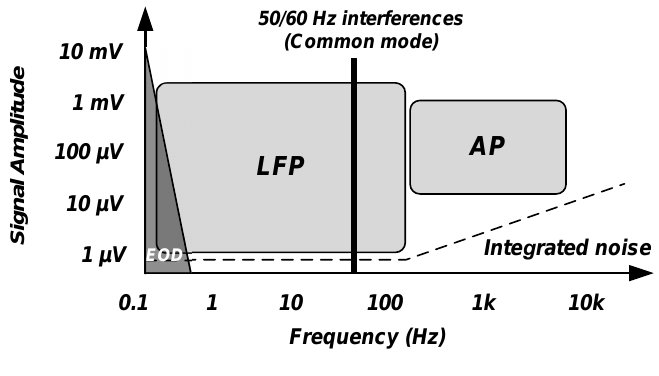
Figure 4. Signals characteristics in neural recording